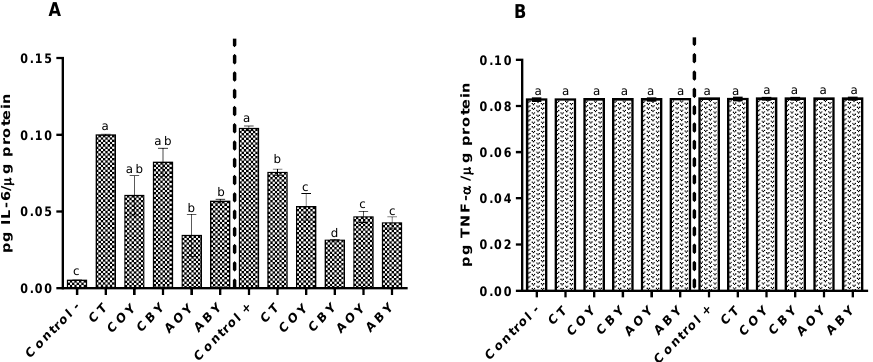
Figure 5. Modulation of inflammatory response in RAW 264.7 cells (( A ) IL-6 secretion; ( B ) TNF- α secretion). The left part of all graphs corresponds to the non-stimulated cell’s response, and the right is related to the anti-inflammatory effect. Different letters mean significant differences as determined by a one-way ANOVA test ( p < 0.05) between samples. Control—is the basal activity, Control + is the basal activity in LPS-stimulated cells. CT—control yogurt, COY—coconut oil yogurt; CBY—coconut bigel yogurt; AOY—avocado oil yogurt; ABY—avocado bigel yogurt.